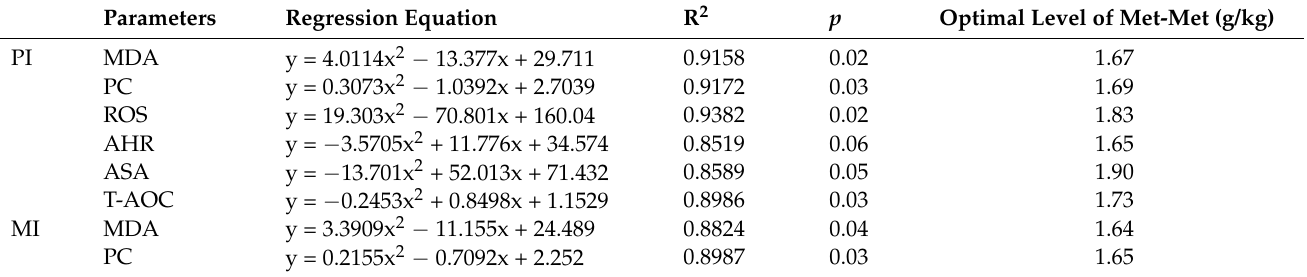
Table 7. The optimal levels of Met-Met supplementation for juvenile grass carp based on the intestinal antioxidant